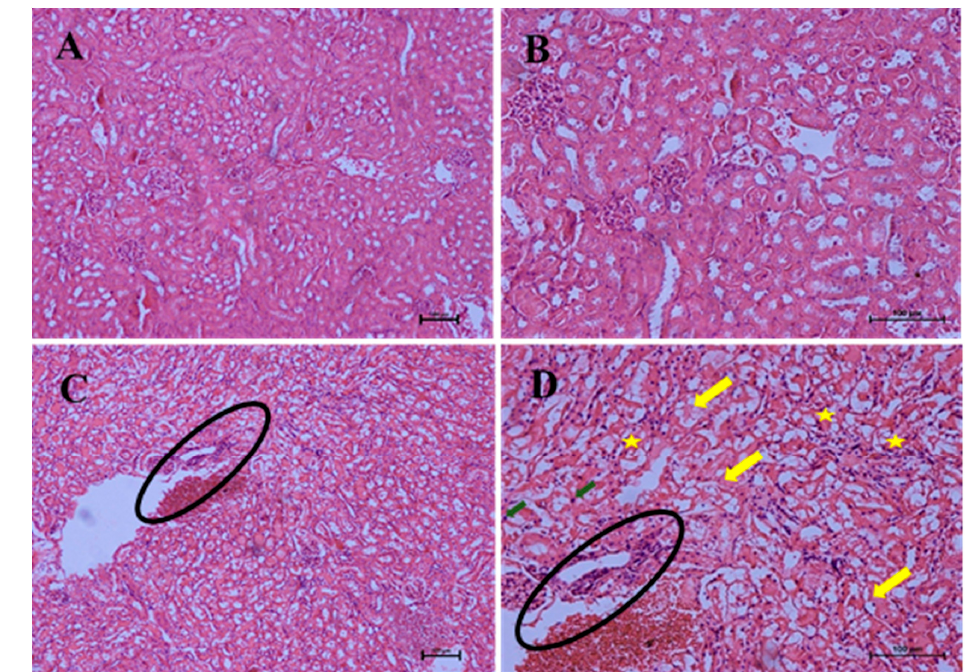
Figure 13. E ff ects of repeated oral administration of CELE for 28 days on the histology of kidney of female ICR mice. Key: ( A ) Photomicrograph of a kidney section (H and E stain × 100) from a mouse in group A showing normal architecture of kidney, ( B ) Higher magnification of A ( × 200), ( C ) Photomicrograph of a kidney section (H and E stain × 100) from a mouse in group E (1000 mg / kg CELE) showing cellular infiltrations (encircled) in the kidney. ( D ) Photomicrograph of a kidney section (H and E stain × 200) from a mouse in group E (1000 mg / kg CELE) showing cellular infiltrations in the kidney (encircled), protein casts (yellow arrows), eosinophilic cytoplasm (star) and pyknosis of the renal tubules (green arrow), CELE = Clinacanthus nutans ethanolic leaf extract, H and E = haematoxylin and eosin. Scale bars represent 100 µ